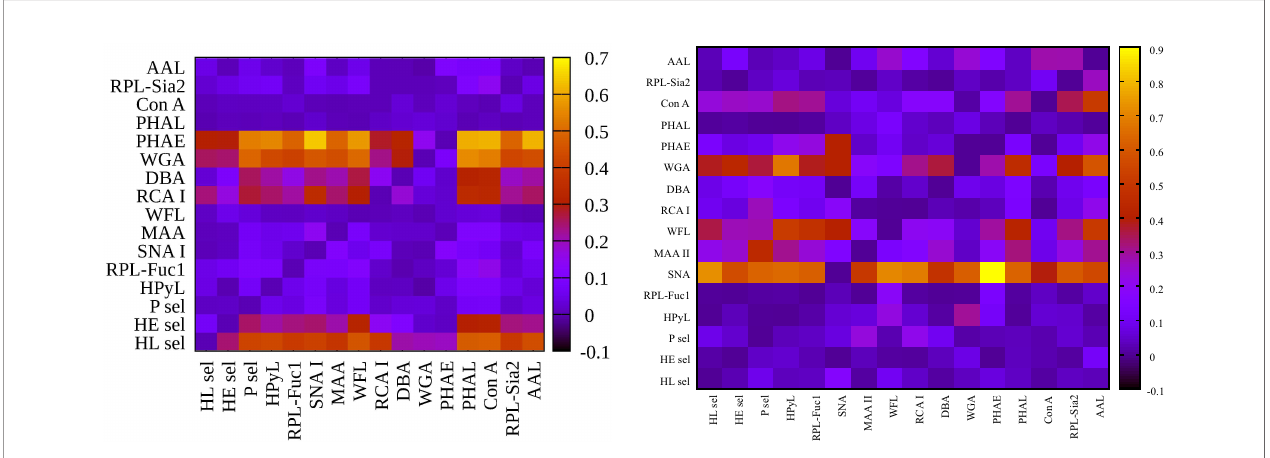
FIGURE 4 | Heat maps for integrated discrimination improvement (IDI) analysis showing hY vs. hO (left) and hO vs. CRC (right).